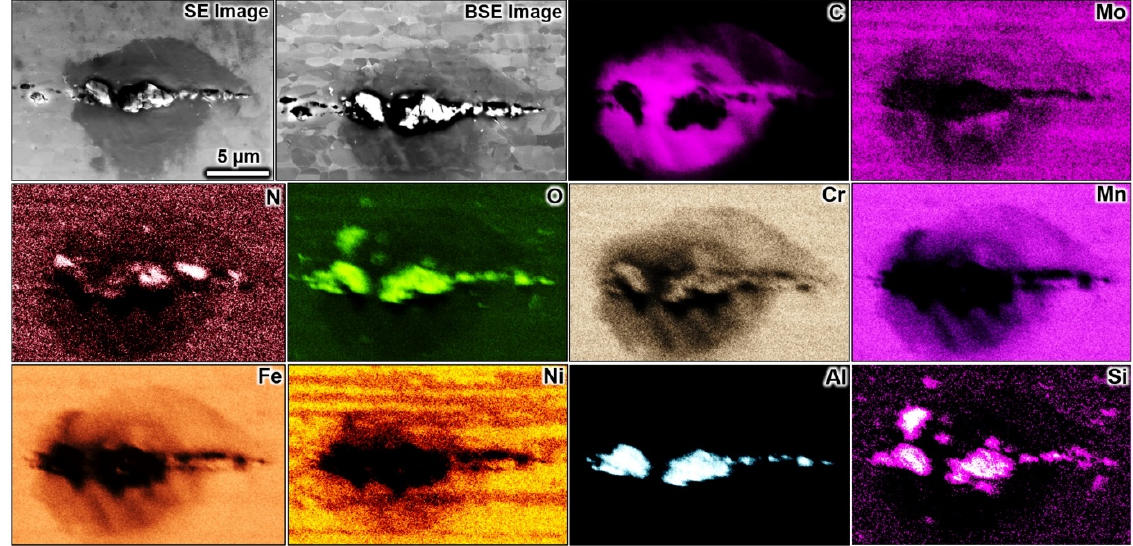
Figure 7. SEM and EDX analysis over a selectively corroded region after potentiostatic polarisation in 0.01 M NaCl at 900 mV vs. Ag/AgCl at pH 3 and 60 °C. The ferrite phase underwent selective corrosion. Corrosion products (Al ‐ Si ‐ N ‐ O) were formed along the corroded ferrite grains indicating selective dissolution of Al, Si, and N. Some minor undercutting dissolutions are also seen, showing fewer signals for Fe, Cr, Ni, and Mo. The rolling direction is directed to the horizontal axis of the images. The scale bar in the SE image applies to all images.